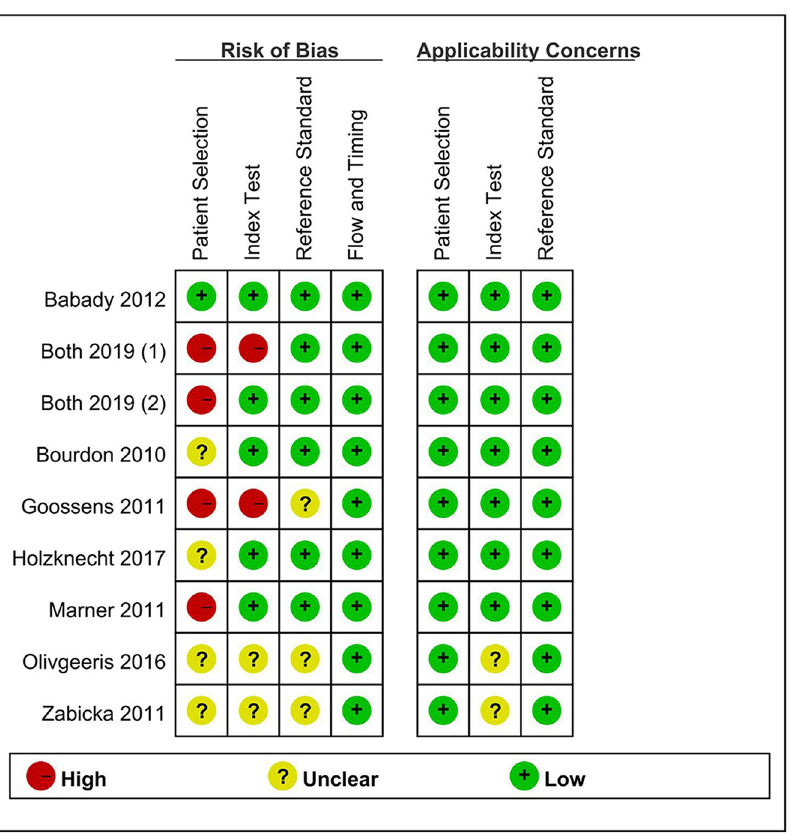
Fig 4. Quality assessment using QUADAS-2 tool for included studies.